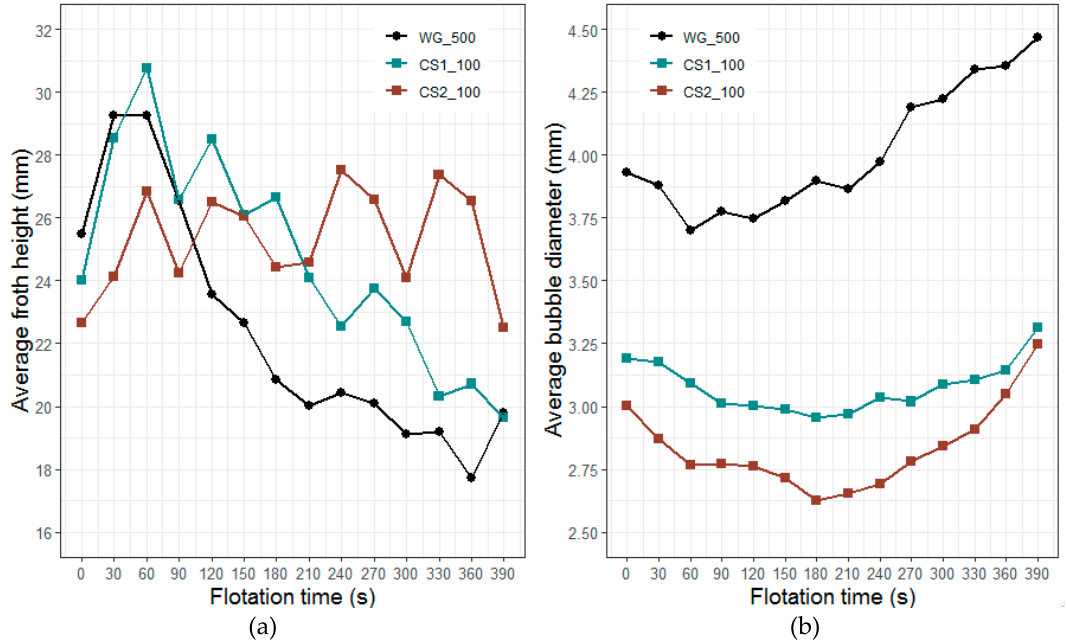
Figure 5. ( a ) Thirty-second average froth height and ( b ) average bubble diameter (by amount of bubbles) over flotation time for WG_500, CS1_100 and CS2_100.